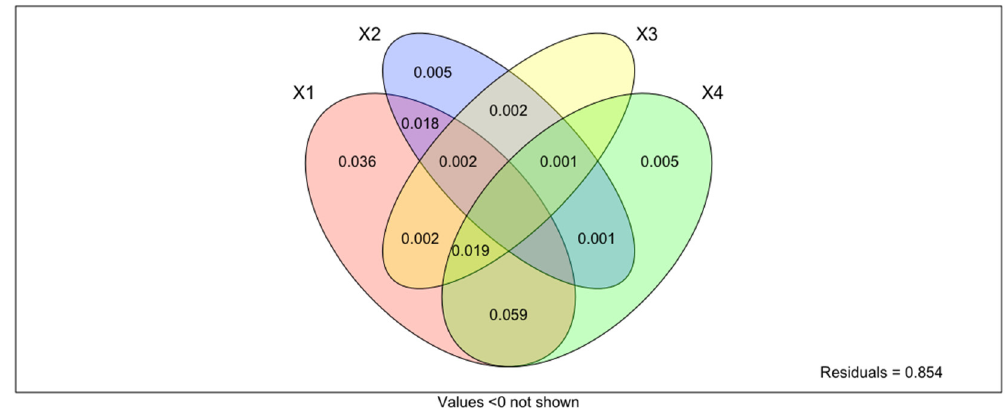
Figure 6. Venn diagrams showing the relative contribution of spatial (X1) and environmental (X2: Depth, X3: Temperature and X4: Sand) components to species distribution.